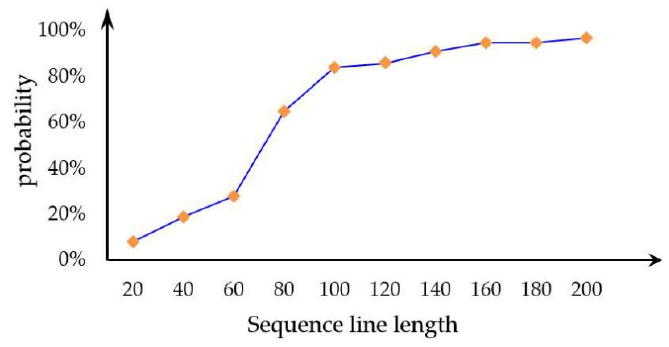
Figure 12. Length threshold analysis.